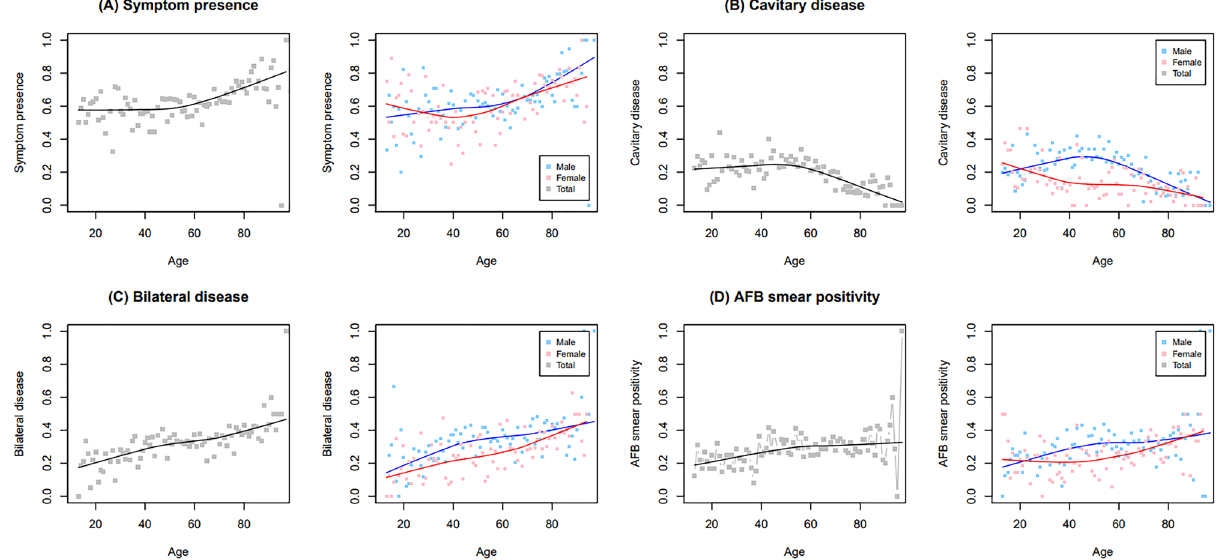
Figure 4. Changes of proportions of disease severity of interest according to age stratified by sex among pulmonary tuberculosis patients: ( A ) symptom presence, ( B ) cavitary disease, ( C ) bilateral disease, and ( D ) AFB smear positivity. AFB acid-fast